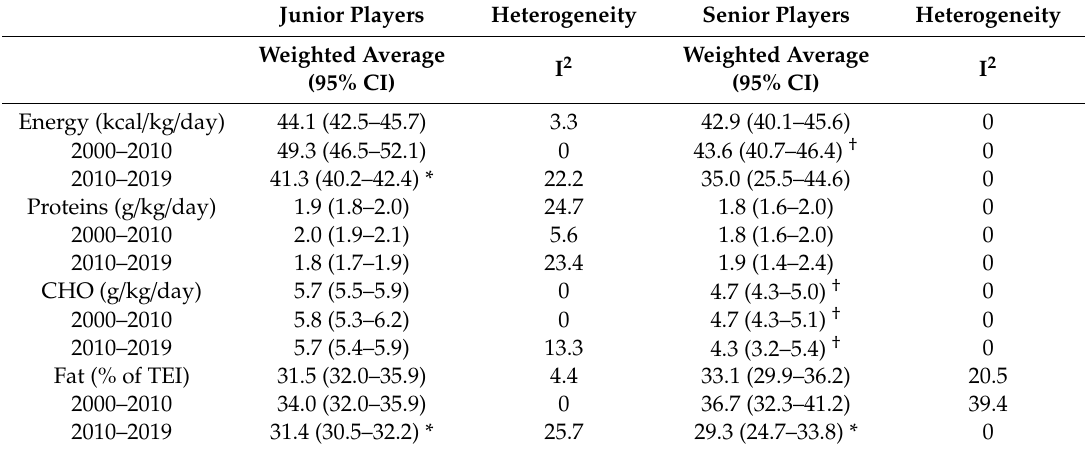
Table 4. Weighted averages and di ff erences between juniors and